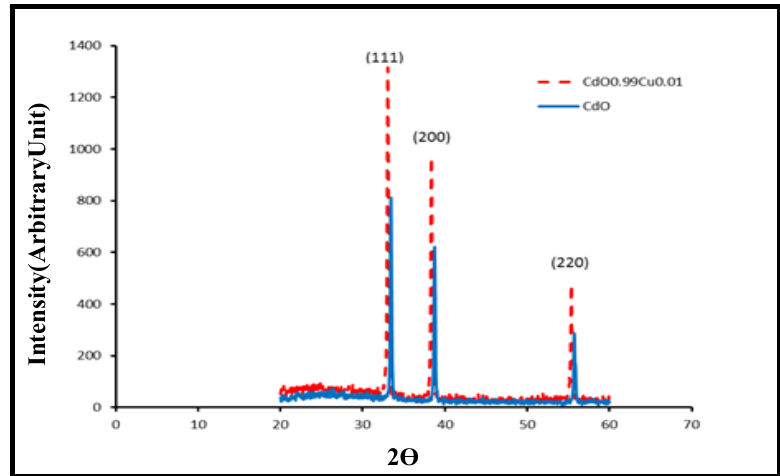
Fig.1: X-ray diffraction pattern of CdO andCdO